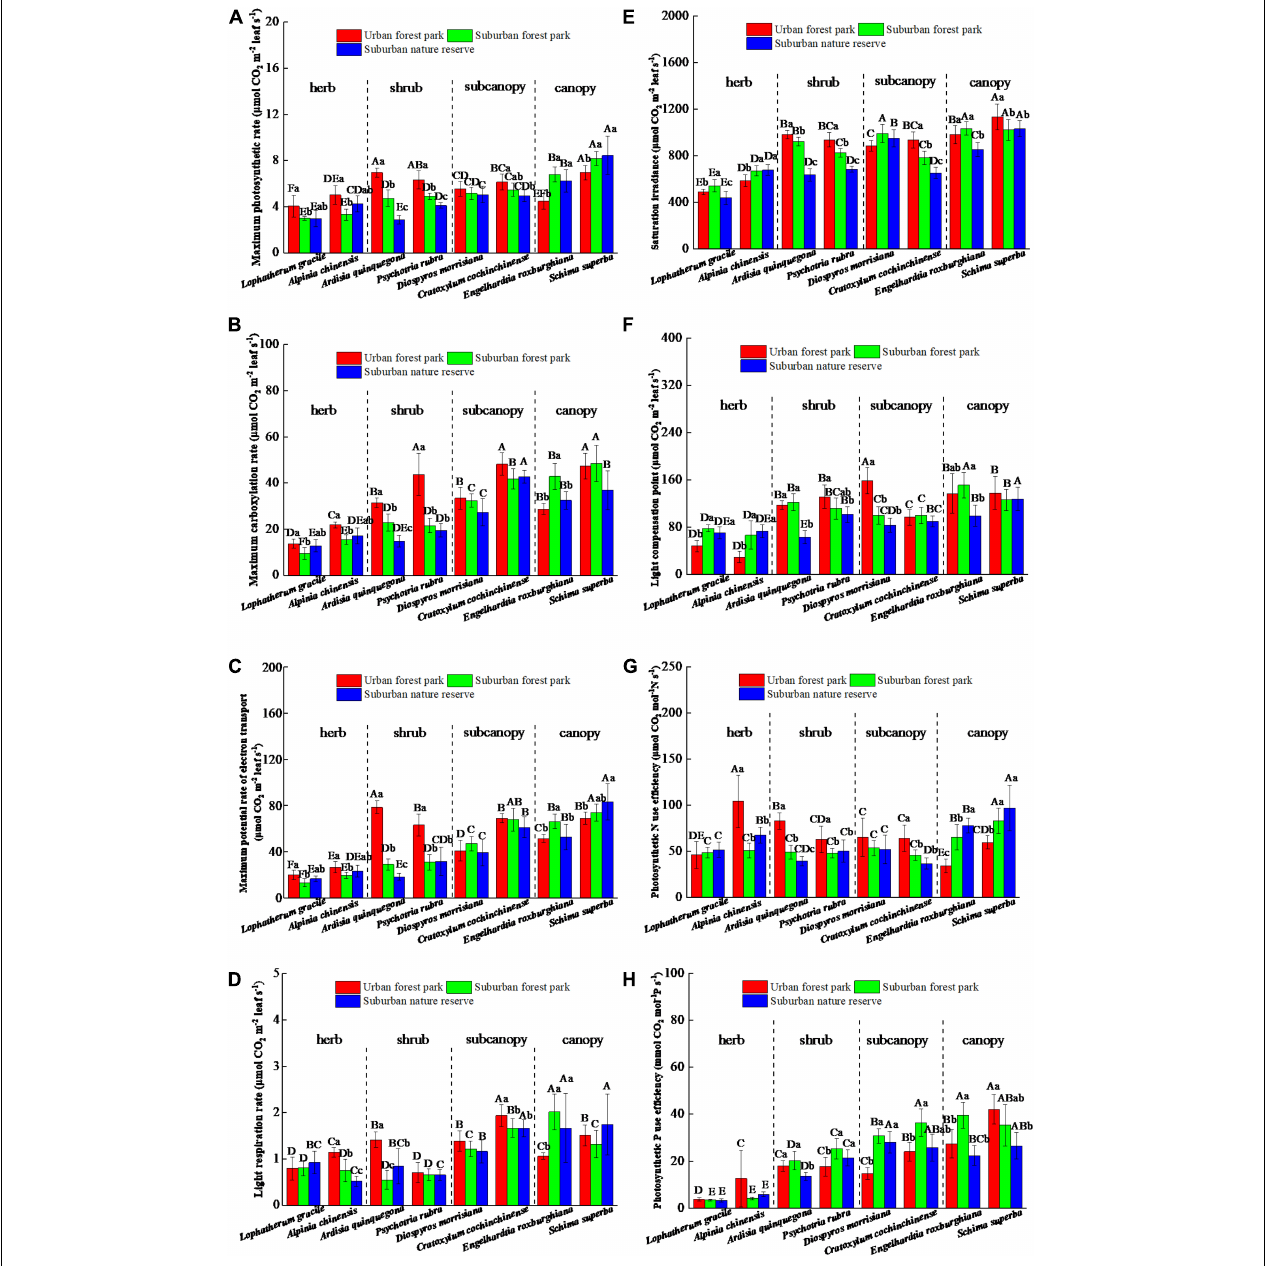
FIGURE 4 | Effects of growth environment on (A) maximum photosynthetic rate, (B) maximum carboxylation rate, (C) maximum potential rate of electron transport, (D) light respiration rate, (E) saturation irradiance, (F) light compensation point, (G) photosynthetic N use efficiency, and (H) photosynthetic P use efficiencies of eight plant species. The lowercase letters reveal the significant differences ( P < 0.05 ) of the same species among different growth environments, and the capital letters reveal the significant differences ( P < 0.05 ) of different species in the same growth